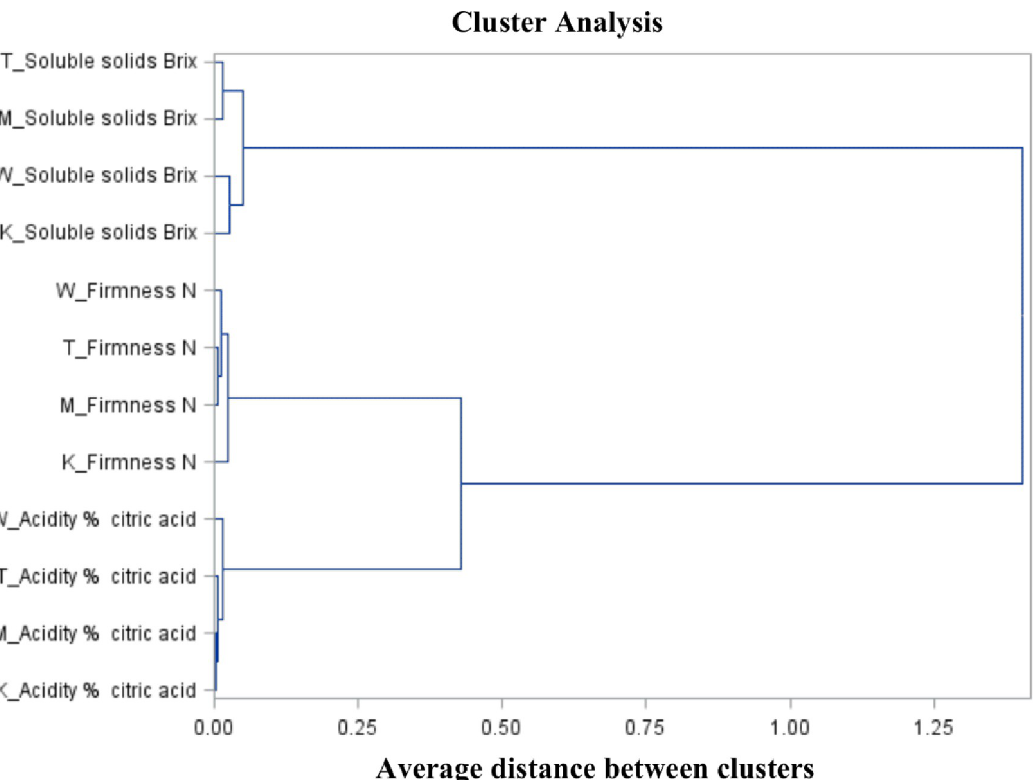
Fig 2. Branching-tree diagram for the extract, firmness and acidity of ´Bluecrop` highbush blueberry fruit.